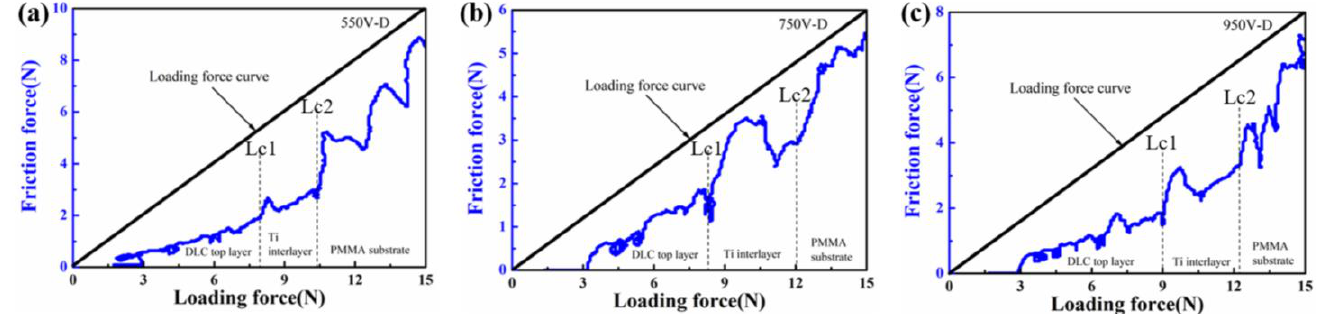
Figure 7. The scratch curves of DLC films deposited on Ti/PMMA at different substrate bias of ( a ) 550 V, ( b ) 750 V, and ( c ) 950 V with conductive material.